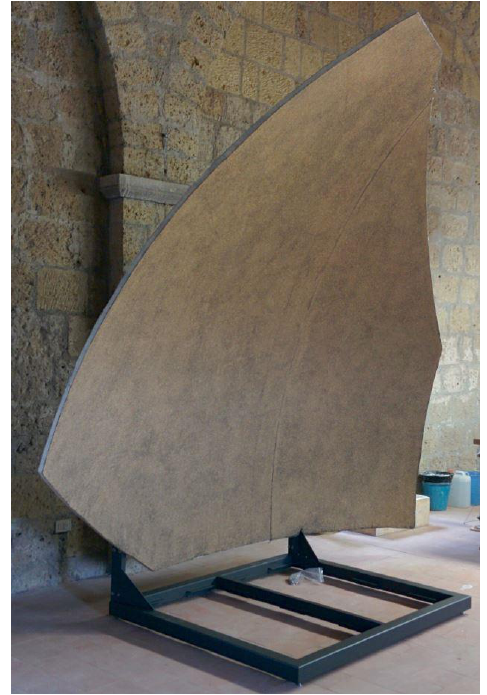
Figure 12. The support panel and structure.